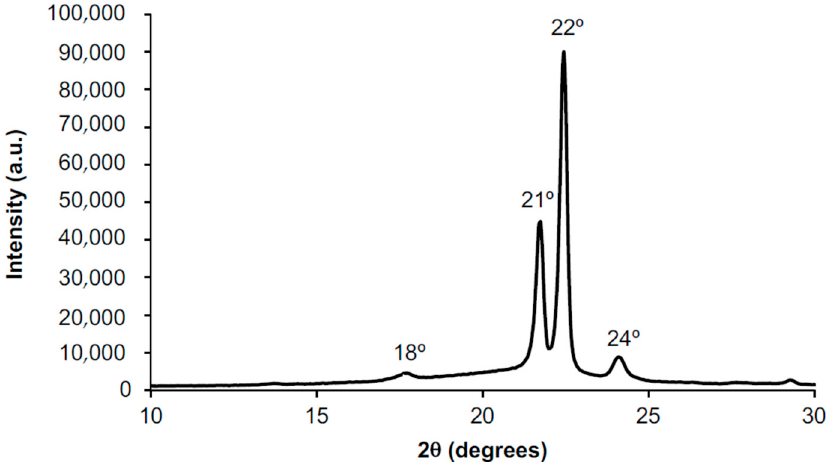
Figure A1. Curve fitting of the carbonyl region of the ATR-IR spectra of 1.30/PPG(75)PAd(25) and 1.30/PPG(25)PAd(75). The term “theoretical” was used to describe the curve fitted spectra by using Gaussian function.